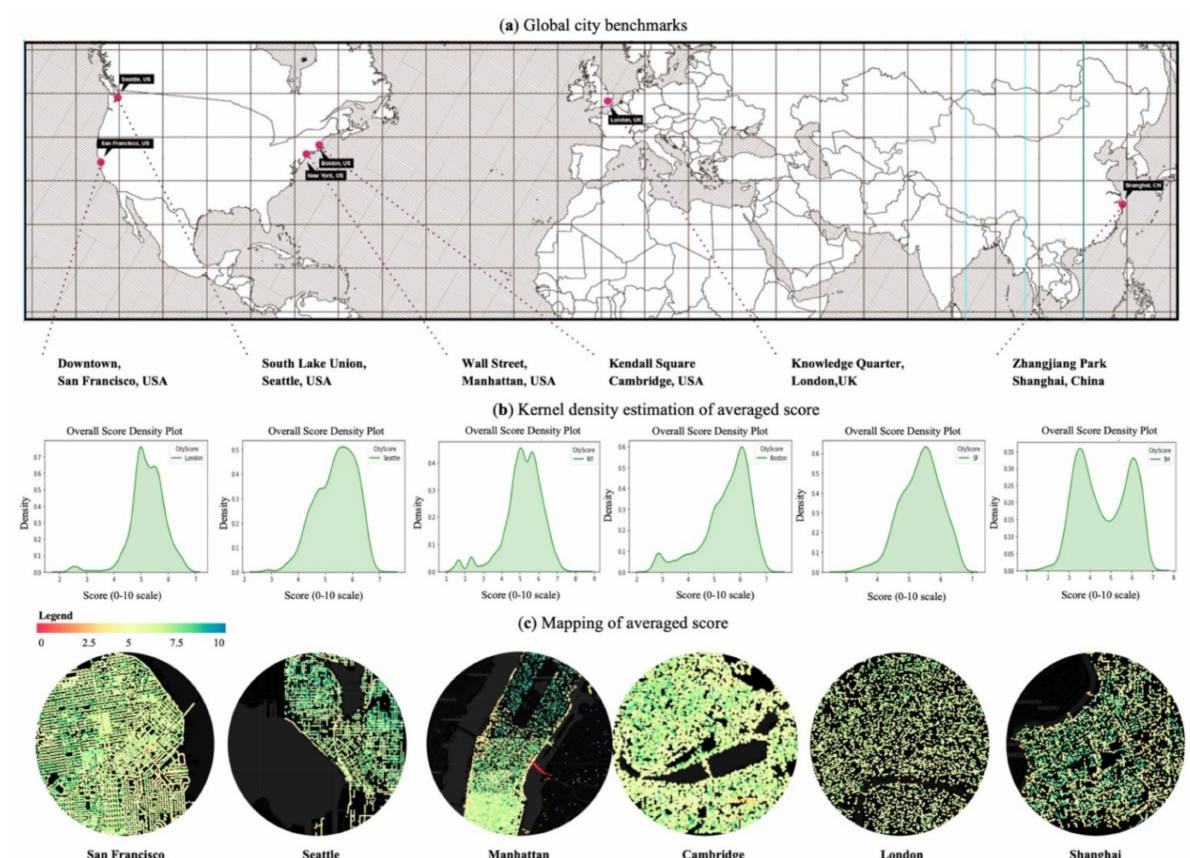
Figure 7. Comparing the perceptual qualities of six cities. ( a ) Locations. ( b ) Average score distribution. ( c ) SVI samples and study area mapping.